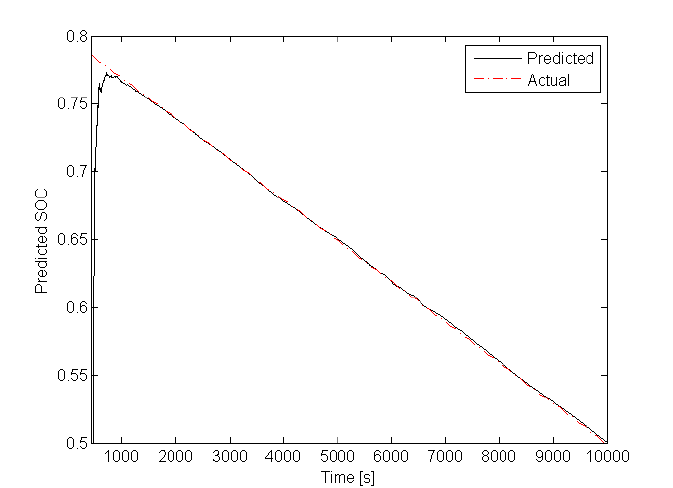
Figure 13. SOC and its